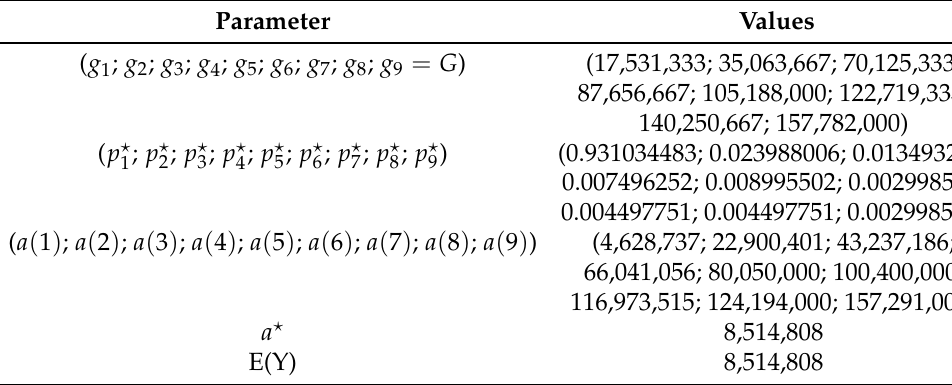
Table 5. 9-States Markov chain values for Group 1.